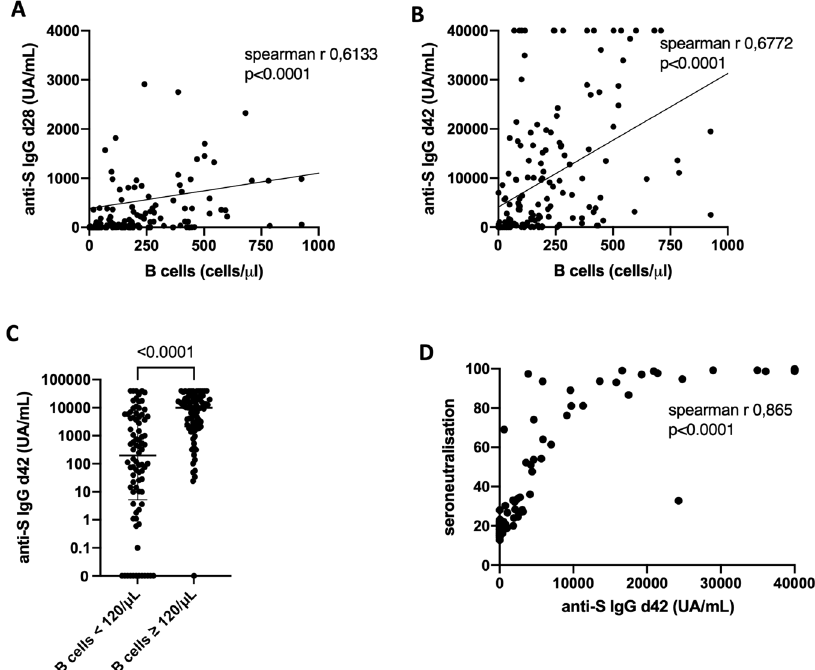
Fig. 3 Correlation between humoral response and B cells and seroneutralization. A, B Correlation between anti-S IgG at d28 ( A ) and d42 ( B ) and CD19 + B cells ( n = 174), patients with circulating pathologic B cells (chronic lymphocytic leukemia not in complete remission and some non-Hodgkin lymphoma patients) were excluded from this analysis. C anti-S IgG antibody at d42 according CD19 + B-cells level. D Correlation between serum neutralization and anti-S IgG antibodies at d42 ( n = patients (60%) who had received two BNT162b2 inocula were patients. In fact, this translated into an increased number of seropositive [8]. We then evaluated in multivariate analysis the patients with seroconversion after a second BNT162b2 inocu- factors predicting seropositivity in patients with hematologic lum, reaching 46.7% of patients. This is in accordance with malignancies, and found that, while underlying diagnosis and preliminary data from others reporting that three out of fi ve